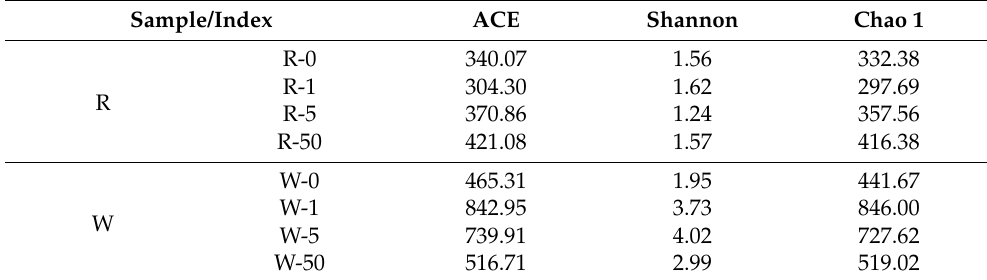
Figure 4. Relative abundance of bacterial groups (class level) based on DNA-derived approaches for each treatment ( a ) and Venn diagrams ( b ). The Venn diagrams show the numbers of OTUs (97% sequence identity) among treatments (R-0, R-1, R-5, and R-50 as rhizosphere samples collected from 0 mg/L, 1 mg/L, 5 mg/L, and 50 mg/L SD treatments, respectively; while W-0, W-1, W-5, and W-50 as water samples, collected from 0 mg/L, 1 mg/L, 5 mg/L, and 50 mg/L SD treatments, respectively). Table 1. Bacterial diversity in different samples analyzed using Ace, Shannon, and Chao 1 diversity.